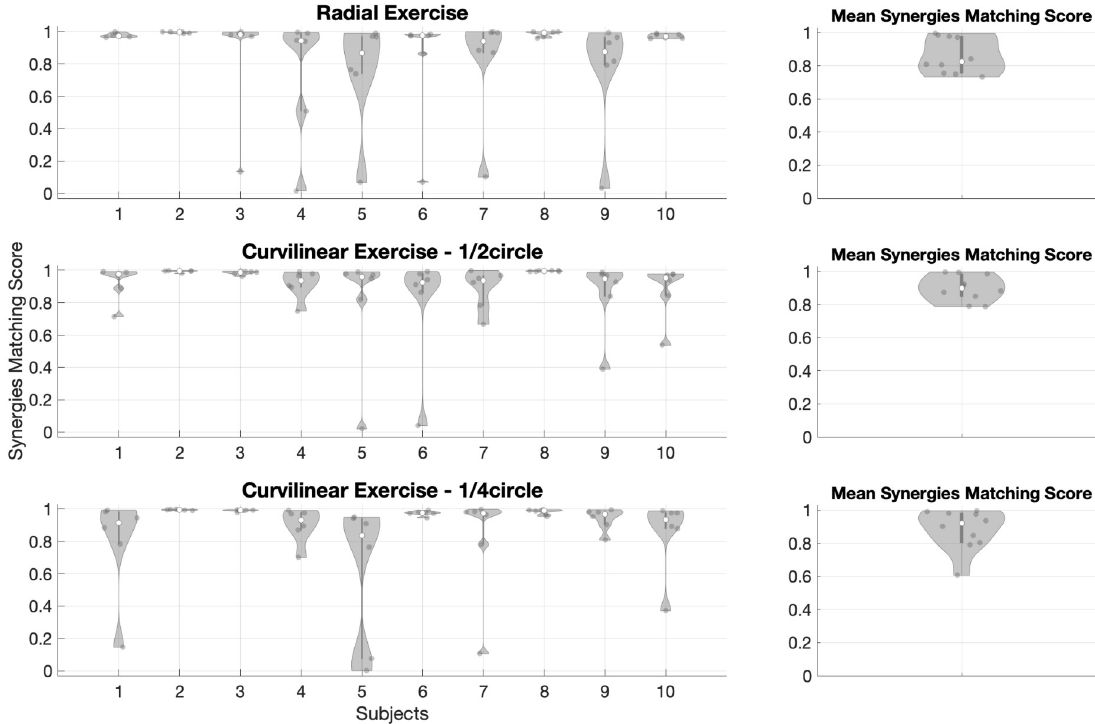
Fig 14. Distribution of mean synergy matching scores (Free vs Assisted). It is portrayed in the Radial exercise (first row), Curvilinear ½ circle exercise (second row), Curvilinear ¼ circle exercise (third row). Our results show that the synergy matching is generally high. In the Radial exercise, statistical tests showed that some subjects’ synergy matching is different from others (subject 5 and subject 9 matchings are lower than subject 2’s); in the Curvilinear ¼ circle exercise, statistical tests showed that some subjects’ synergy matching is different from others (subject 2 and subject 3 matchings are lower than subject 5’s); in the Curvilinear ½ circle exercise, statistical tests showed that some subjects’ synergy matching is different from others (subject 9 and subject 10 matchings are lower than subject 8’s). The mean Synergies Matching Score for all subjects is reported for both